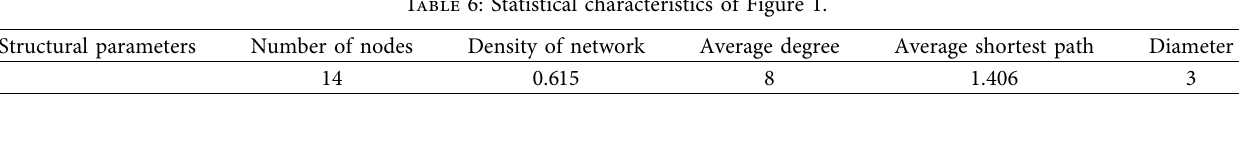
Table 7: Degree value of nodes in network topology network of vulnerability influencing factors.